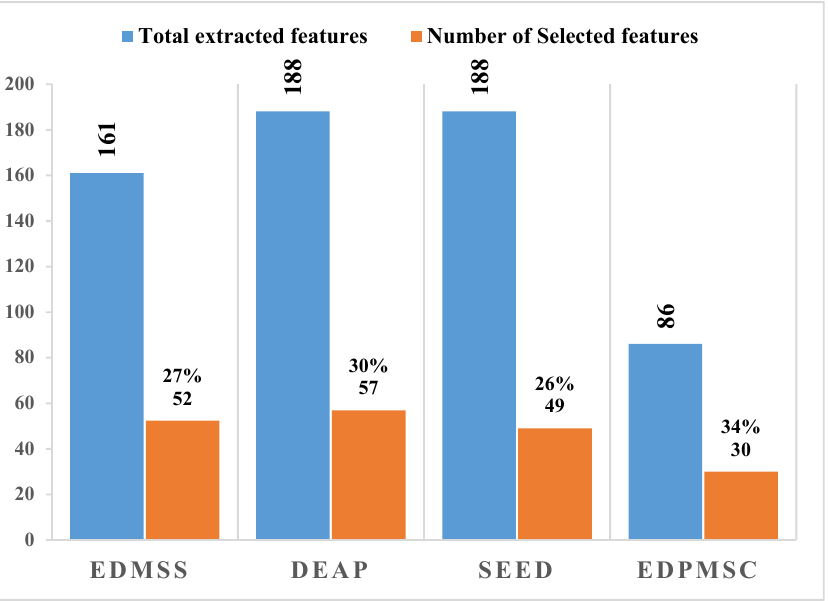
Figure 5. A total number of multi-domain features were selected using mRMR-PSO-SVM.